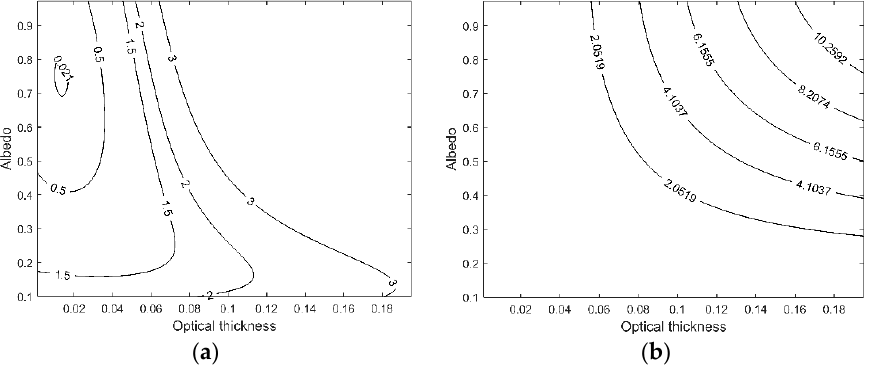
Figure 6. The contours of cost function with constraints ( a ) and without constraints ( b ), using a simulated test case.